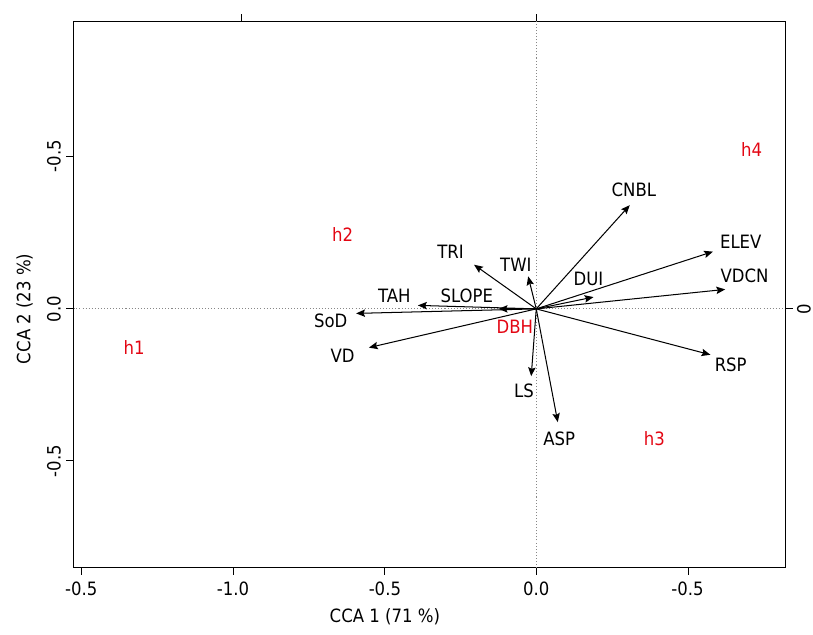
Figure 5. Ordination diagram of canonical correlation analysis (CCA) of axes 1–2 based on principal components of edaphic and dendrometric variables of a Pinus taeda commercial plantation, Campo Belo do Sul, Santa Catarina, in which the pedological variables are: solum depth (SoD) and thickness of A horizon (TAH). Topographic variables are: elevation (ELEV); valley depth (VD); vertical distance to channel network (VDCN); relative slope position (RSP); slope; terrain ruggedness index (TRI); topographic wetness index (TWI); channel network base level (CNBL); duration of insolation (DUI); LS factor (LS). Dendrometric variables are: diameter at breast height (DBH); total tree height (h); high level 1 (h1); high level 2 (h2); high level 3 (h3); high level 4